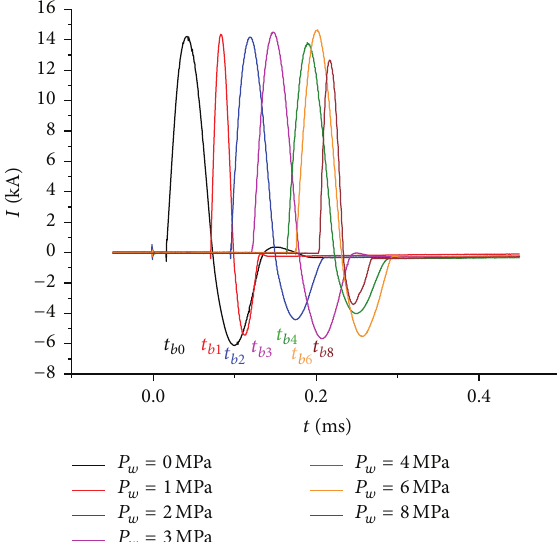
Figure 7: Plot of 𝐼(𝑡) and 𝑡 𝑏 with a charging voltage of 8KV and different hydrostatic